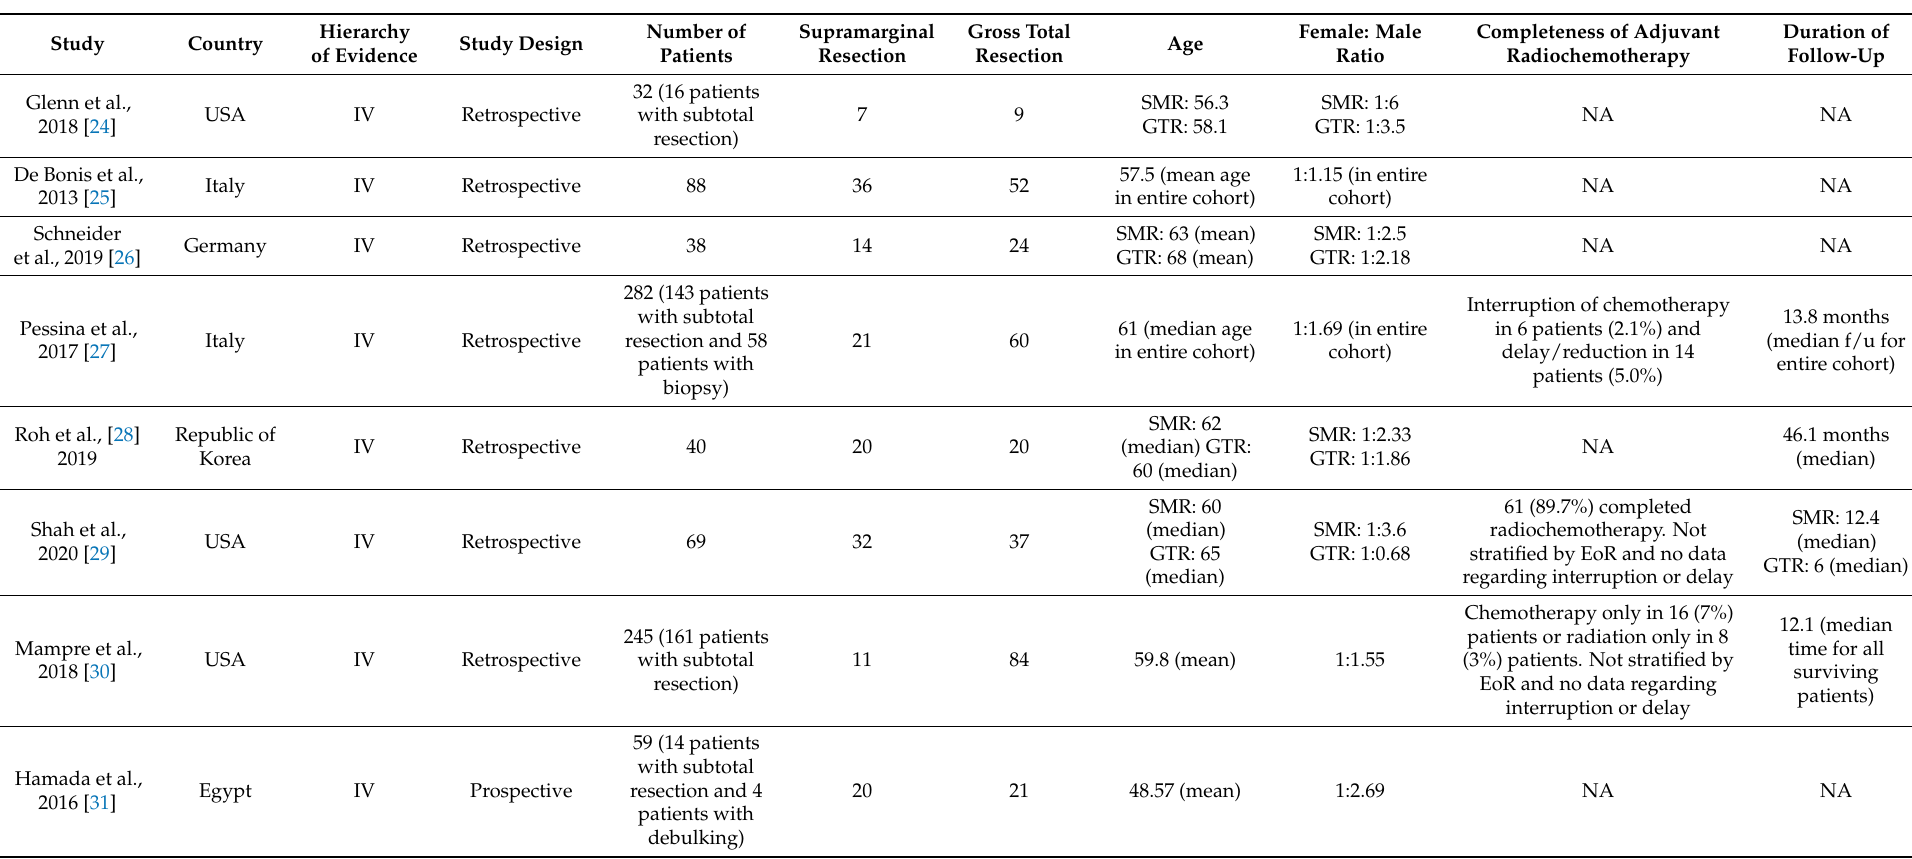
Table 1. Summary of systematic review of studies comparing supramarginal and gross total resection in GB regarding progression-free